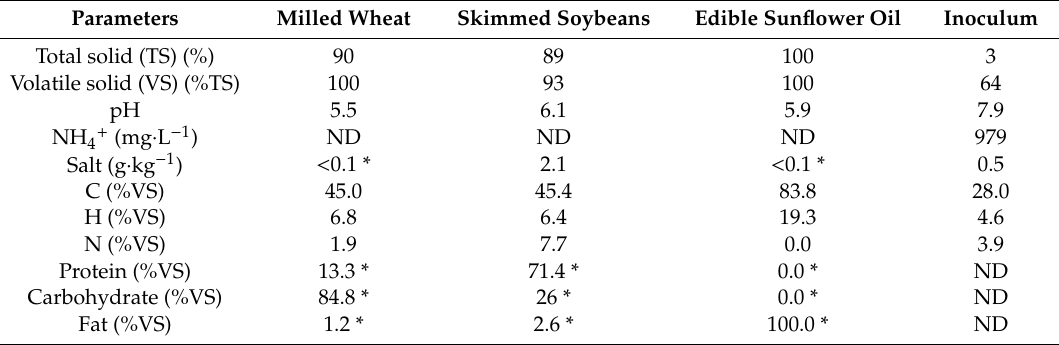
Table 1. The characteristics of wheat, skimmed soybeans, edible oil and